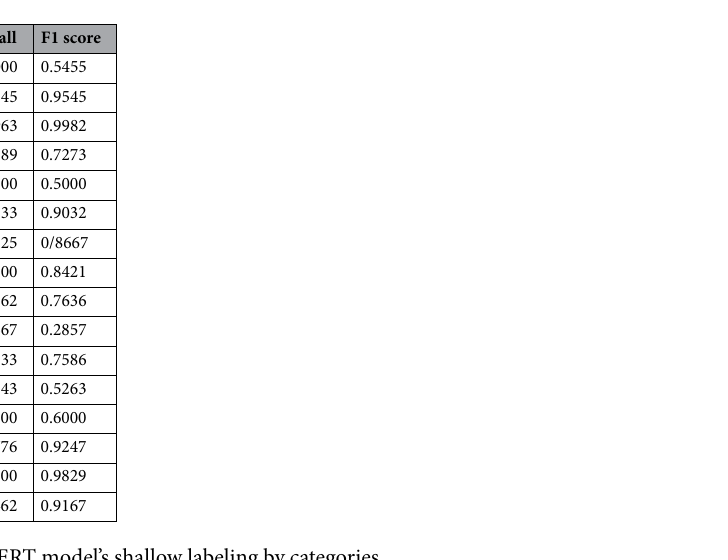
Table 4. The results of the BERT model’s shallow labeling by categories.